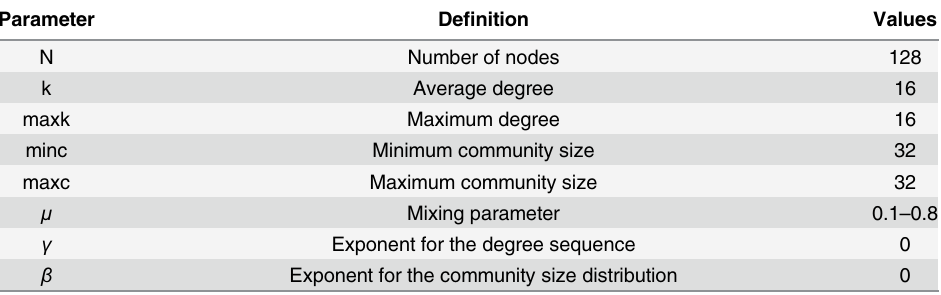
Table 3. Summary of generated GN networks.